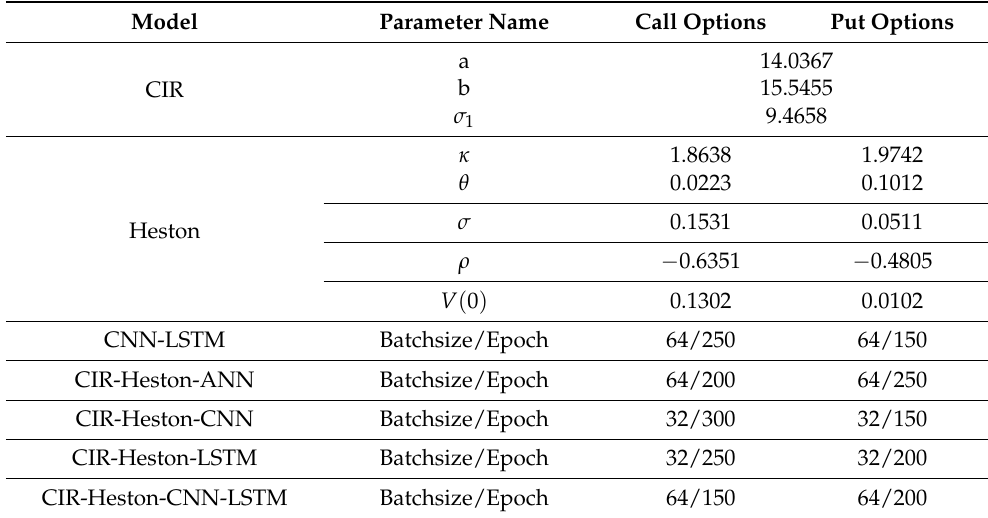
Table 3. Parameter setting table of the